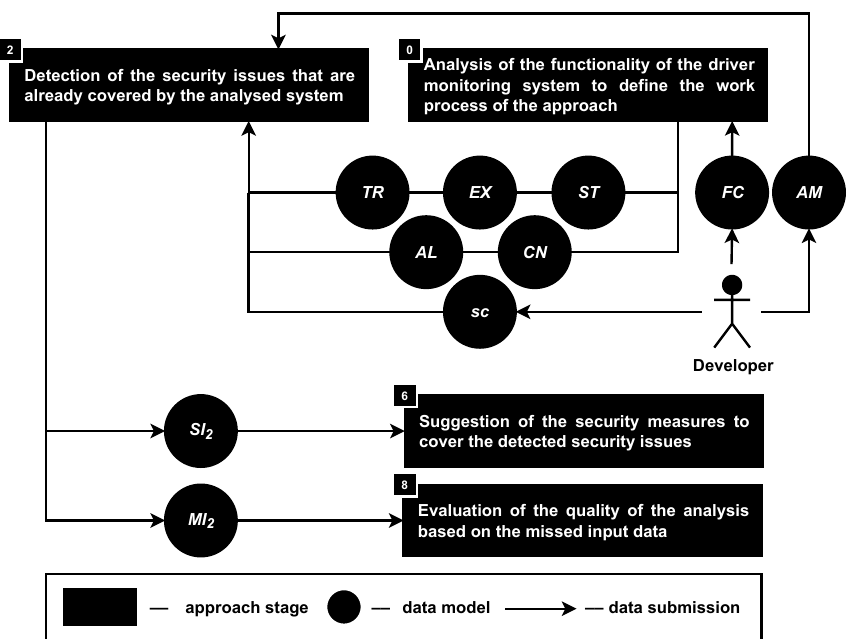
Figure 5. Stage 2—Detection of the covered security